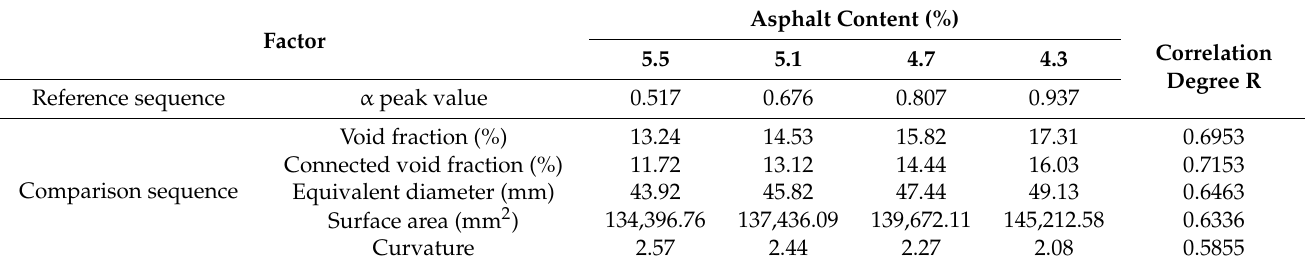
Table 13. Gray correlation analysis of the peak sound absorption coefficient and void characteristic